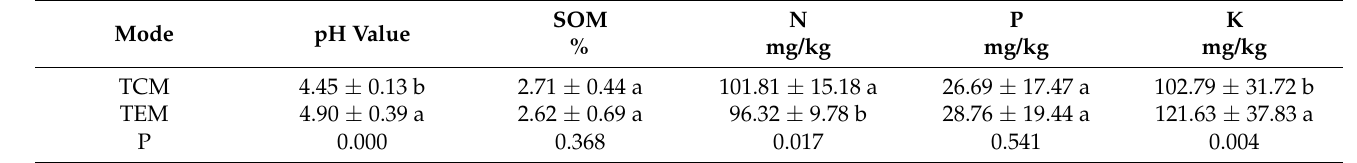
Note: The different letters labeled in columns are significantly different according to Duncan’s test ( p <